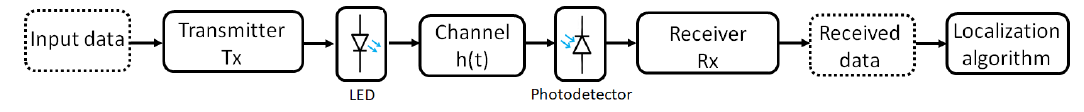
Figure 3. General block diagram of the proposed VLC system.